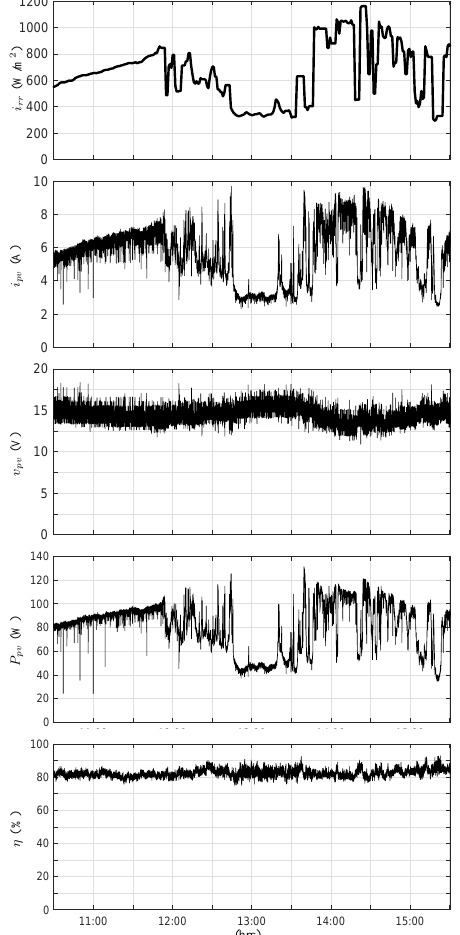
Figure 19. Time responses of the switching converter with an MPPT perturb and observe algorithm. ( Top ) to ( bottom ): Measured global solar irradiance, generated current of the PV module, voltage at the terminals, power developed by the PV module, and efficiency (partially cloudy